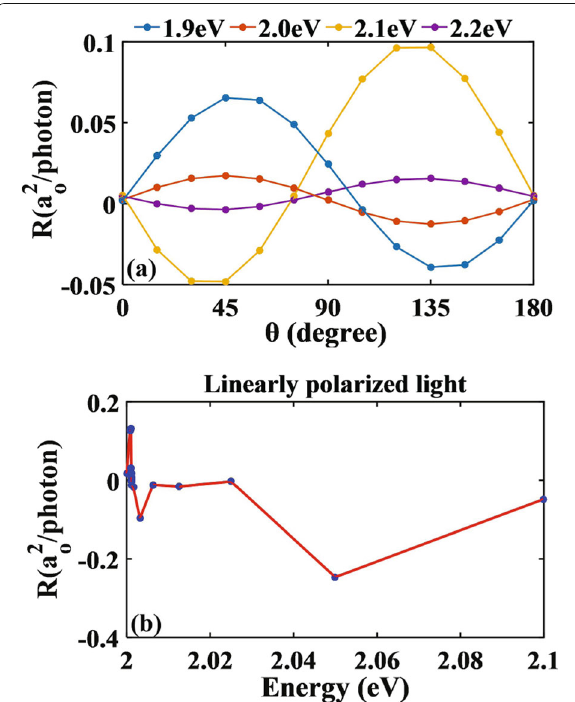
Fig. 5 Behavior of photoresponse function for nitrogen-doped monolayer MoS 2 irradiated by the linearly polarized light perpendicularly. Variation of photoresponse function with a the polarized angles and b the energies of linearly polarized light for θ = π/ 4